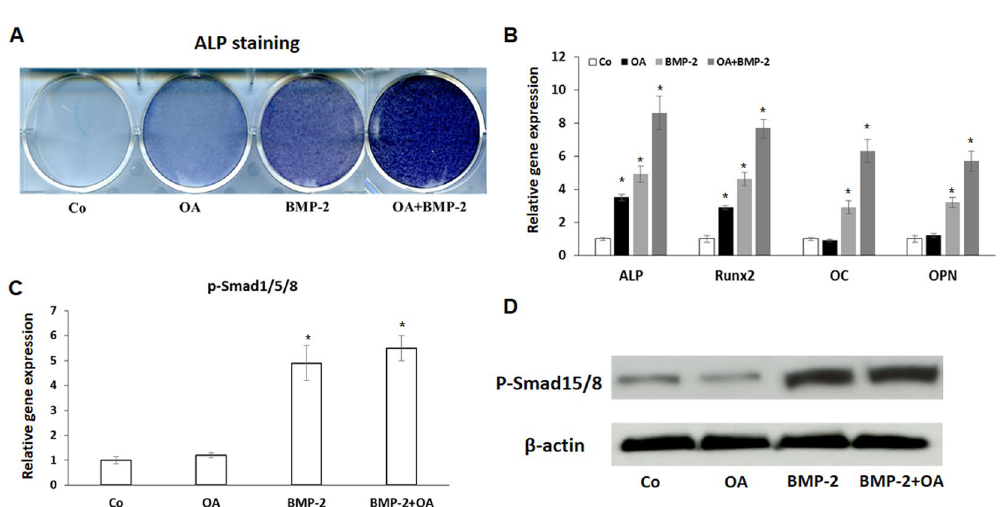
Figure 3. Synergistic effect of OA and BMP2 on MSC osteogenic differentiation. ( A ) ALP staining showed a significant increase of ALP activity in MSCs treated with either OA or BMP2, and this increase is further enhanced by the combined treatment at day 7. ( B ) Real time RT-PCR analysis reveals that expression of both early and later osteogenic markers (ALP, Runx2, OC, OPN) were significantly enhanced by combined treatment with OA and BMP2 at day 7 when compared with either OA or BMP2 alone treated MSCs. PCR data is means ± s.d. of three independent experiments performed in duplicate and all the results were normalized to control ( * p < 0.05 compared with control MSCs (Co) without treatment). ( C ) RT-PCR data shows treatment of OA in MSCs did not cause a significant change in gene expression of phosphor-smad1/5/8 at day 7. Data is the means ± s.d. of three independent experiments. ( * p < 0.05 compared with control MSCs). ( D ) Western Blot shows phosphor-smad1/5/8 (p-smad1/5/8) protein levels were not affected by OA treatment in MSC culture at day 7. β -actin was used as a loading control. Full-length blots/gels are presented in Supplementary Figure